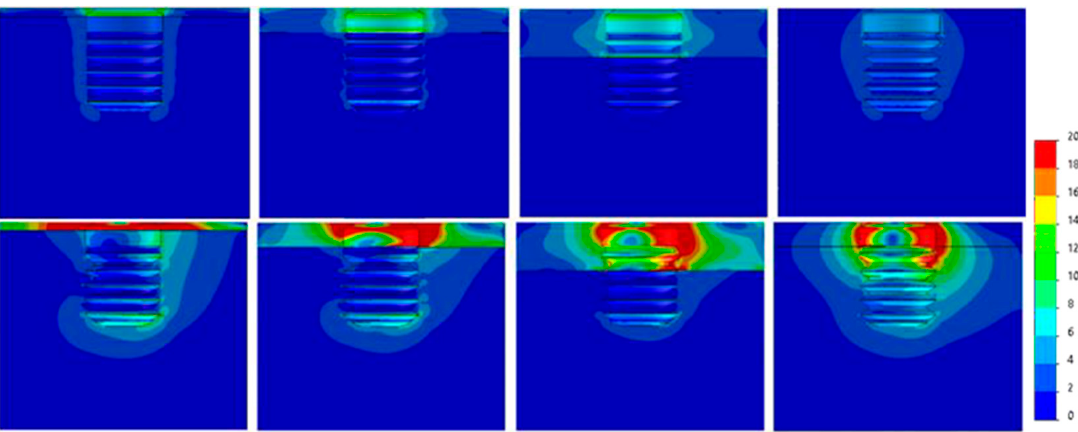
Figure 12. Von Mises equivalent stress (MPa) for Ø4.75 implant cases. Above, axial load, below, angled load. From left to right, Type IV, III, II, 0-I bone.